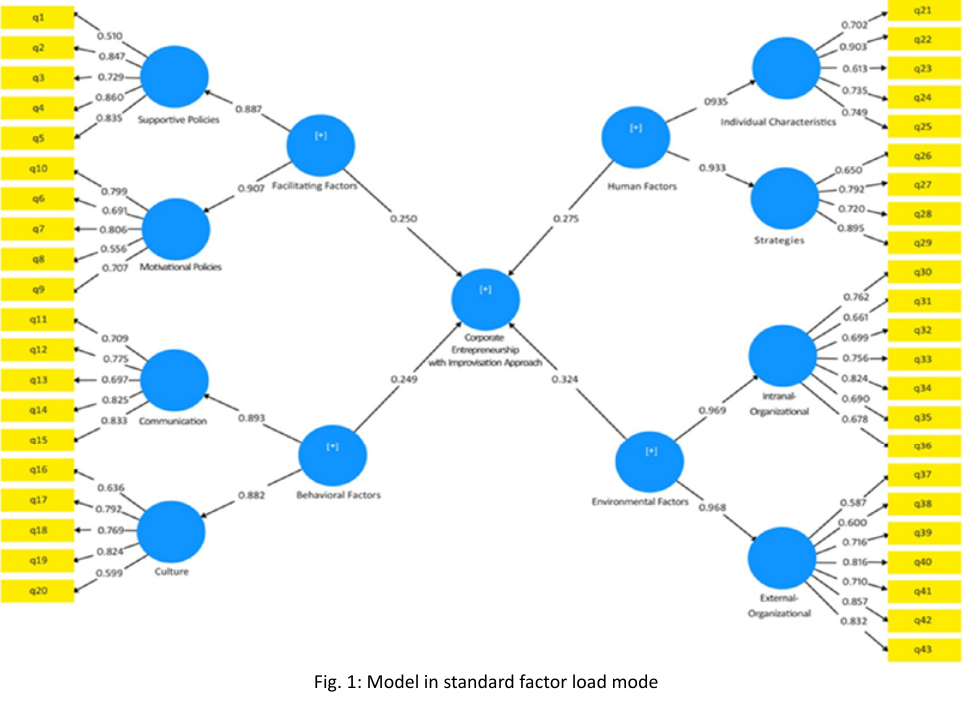
Fig. 1: Model in standard factor load mode Fig. 2: t‐ statistics value